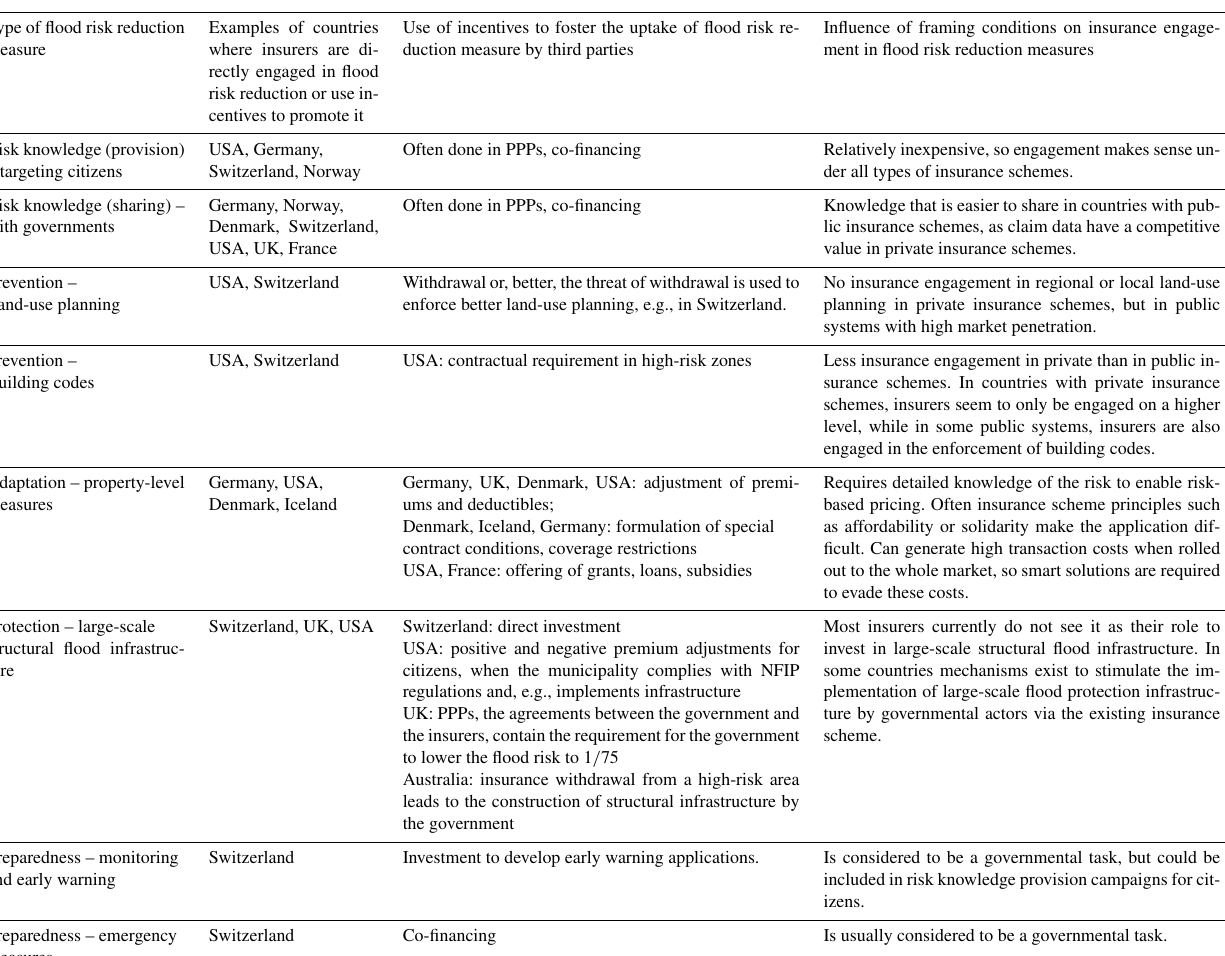
Table 2. Overview of insurance engagement in flood risk reduction measures and their use of incentives, contrasted with the framing condi-